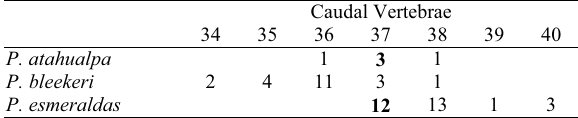
Table 28. Number of specimens of the species of Paracetopsis with cited number of caudal vertebrae. Bold indicates value for holotype when examined.